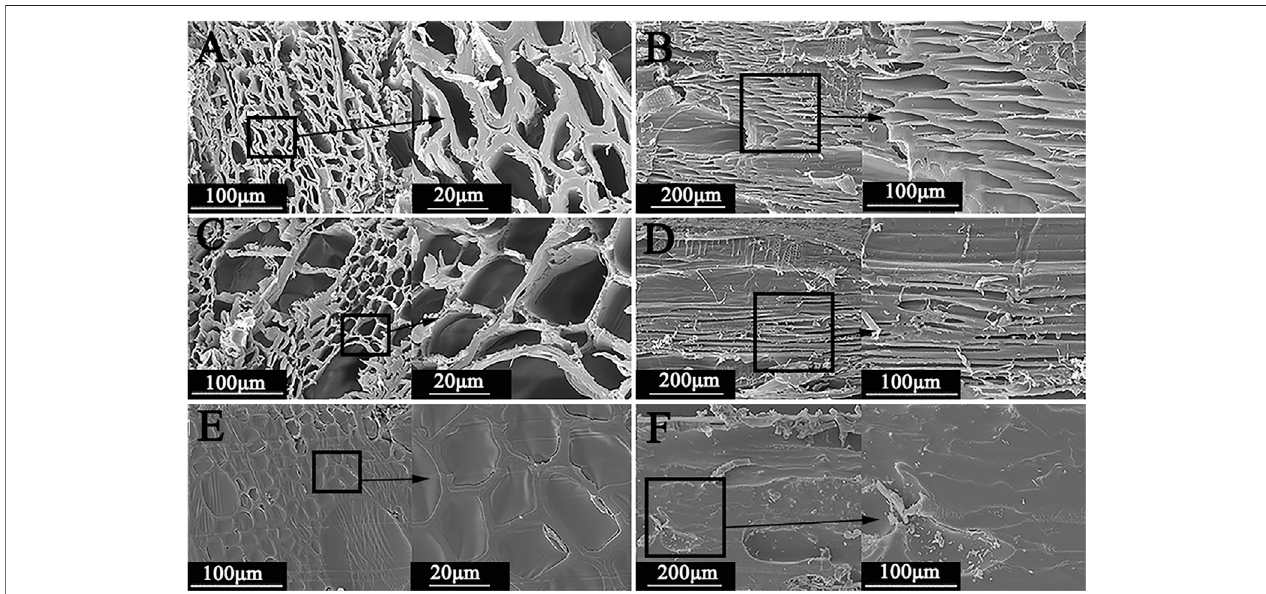
FIGURE 4 | SEM image of poplar with thickness of 0.5 mm before and after treatment ( A .A; B .B; C . DW-A; D . DW-B; E .TW-A; F .TW-B).